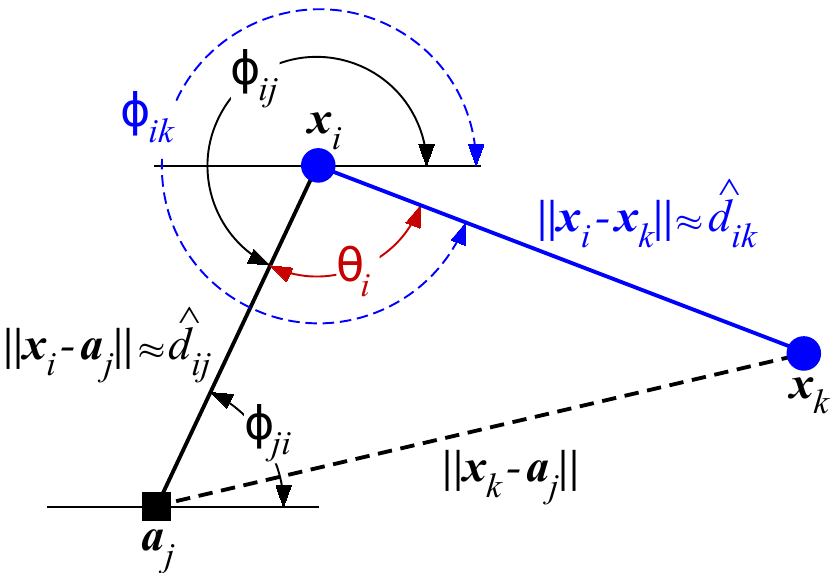
Figure 10. Illustration of the geometric approach in [68] for a 2-hop case.